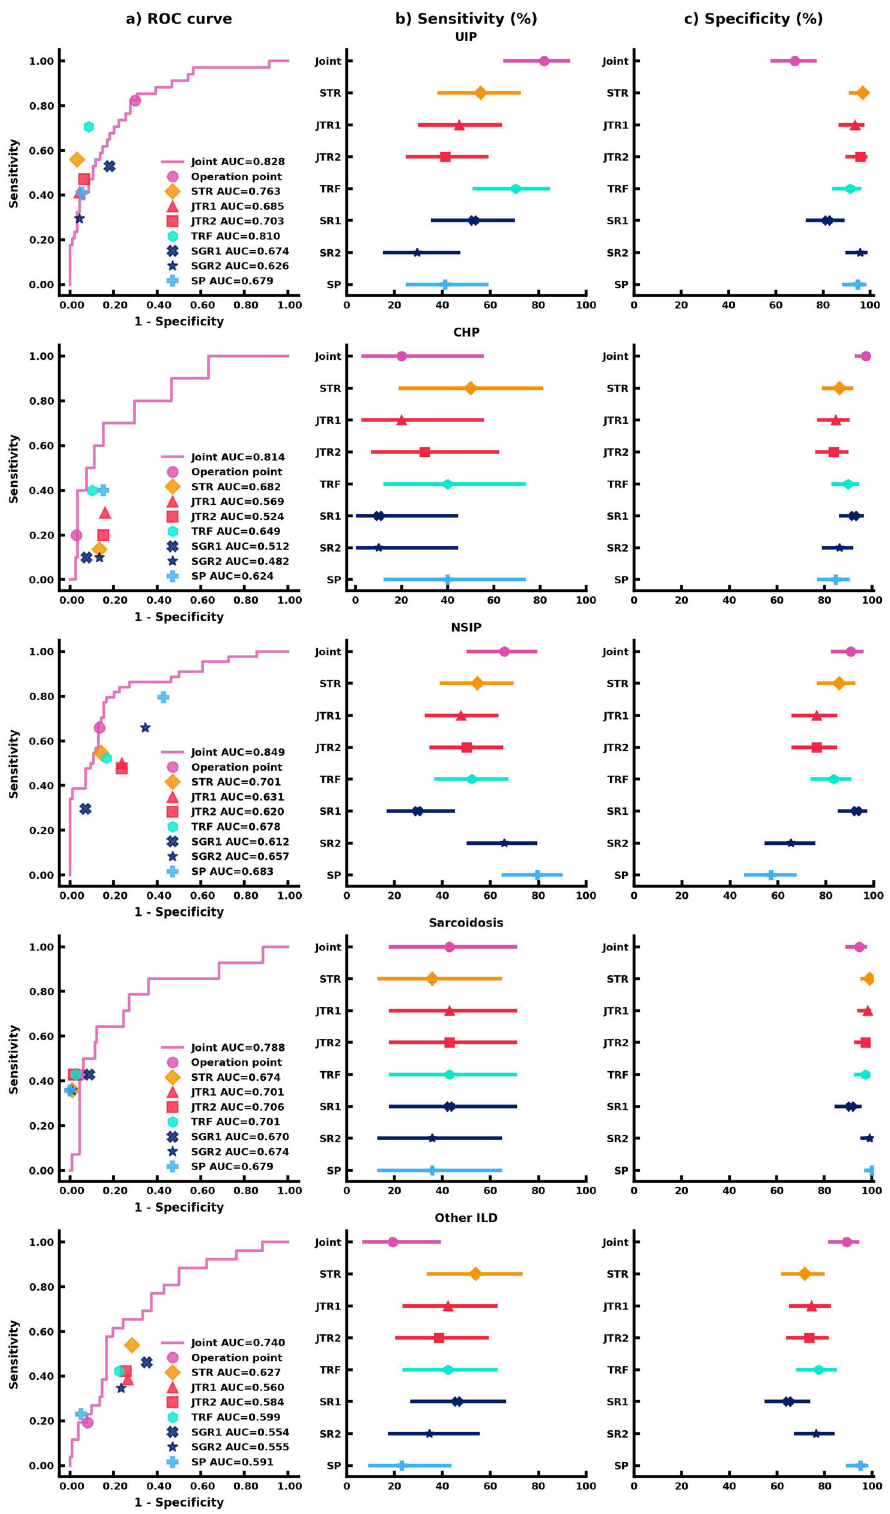
Fig. 3 | Results of the AI model on the ILD classi fi cation. a AUC comparison between the joint AI model and human readers on the classi fi cation of each ILD subtype. The ( b ) Sensitivity analysis of the joint AI model and human readers ’ results. The markers represent the sensitivity of the AI model and human readers on eachILDsubtype, and the lines represent the con fi denceintervalofsensitivity. c Speci fi cityanalysisofthejointAImodelandhumanreaders ’ results.Themarkers